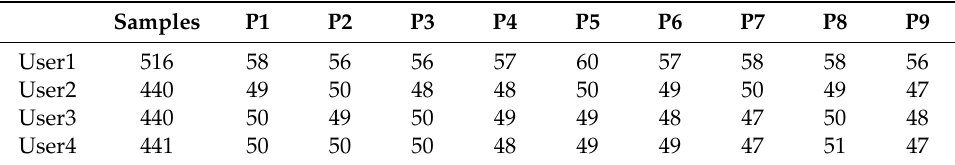
Table 5. Number of samples. Table 5. number of samples.